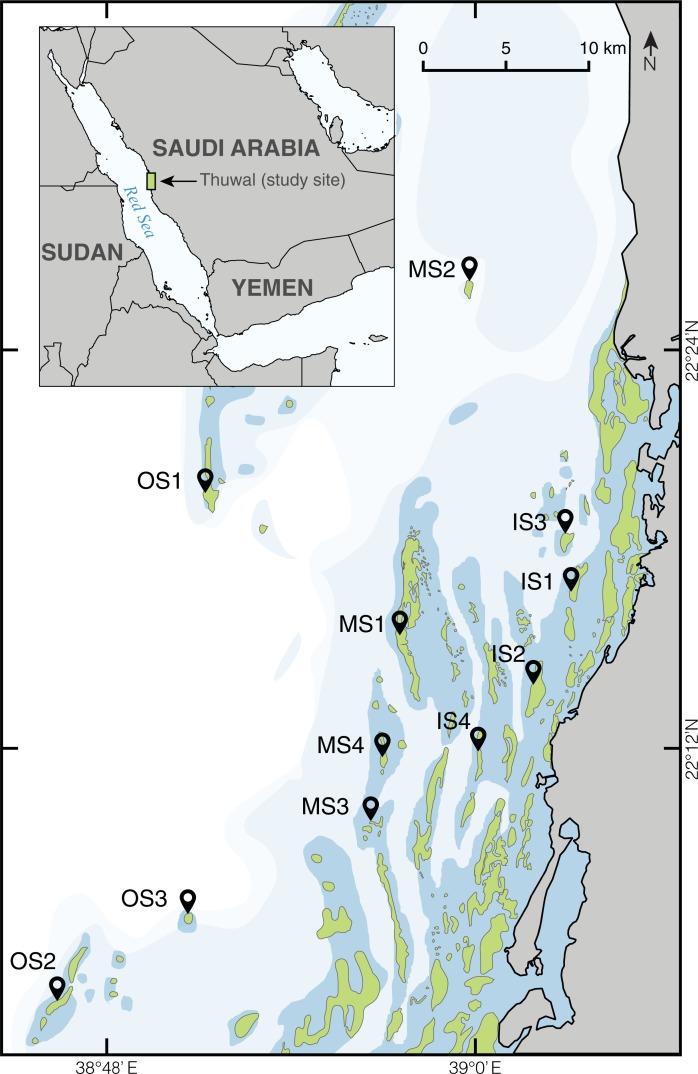
Map of the 11 reefs surveyed off the coast of Thuwal, Saudi Arabia in the central Red Sea in September 2015.Abbreviations are as follows: OS (offshore), MS (midshelf), and IS (inshore). Modified and reprinted from [26] under a CC BY license, with permission from Springer Nature, Coral Reefs (2017)(S2 File).